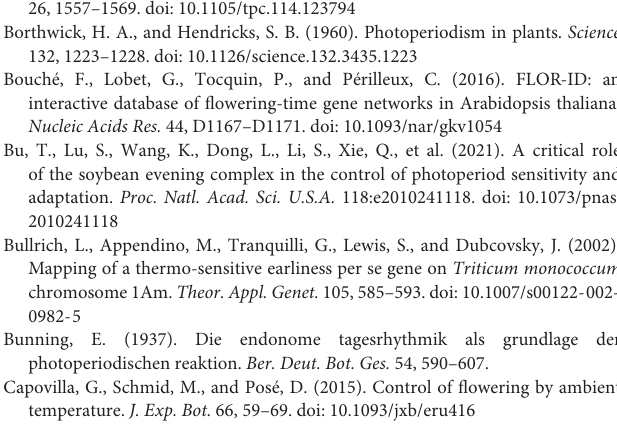
Supplementary Figure 1 | Spectra and light conditions records. (A) Spectral distribution of white, red, and far-red lights used during night breaks and end-of-day far-red treatments. (B) Diurnal monitoring of far-red, total light, and photosynthetically active radiations (PAR) intensities for plants exposed to 18 h long day (LD) followed by 1 h end-of-day far-red (FR) treatment (left) or not (right). Supplementary Figure 2 | Example of a Derived Cleaved Amplified Polymorphic Sequence for elf3 genotyping. The PCR was performed using the dCAPS primer pair shown in Supplementary Table 1 . The PCR product was digested using the hpy166ii restriction enzyme (NEB, United States), which cuts only into the WT ( + ) sequences, creating shorter fragments than in mutated ELF3 sequences (–). The elf3 mutant phenotypes segregated perfectly with the homozygous elf3 mutation. Supplementary Figure 3 | Complementation of elf3 mutant with the UBI:ELF3 construct. Six independent transgenic lines exhibited rescue of the rapid flowering phenotype in the T0 generation under 16-h LD. Controls were sown 3 weeks before transplantation of T0 lines to soil. The picture was taken 45 days after transplantation to soil. Supplementary Figure 4 | Flowering phenotype of elf3 mutants overexpressing VRN1 . Individuals were segregated from the elf3 ; UBI : VRN1 F2 population. The picture was taken 110 days after germination under 8 h SD. elf3 mutant flowered after 86.5 ± 13.7 days ( n = 15), elf3 ; UBI : VRN1 flowered after 36.3 ± 2.9 days ( n = 27). WT and UBI:VRN1 plants had not flowered after 180 days. Supplementary Figure 5 | Expression kinetics of CO1 in the elf3 mutant. Relative expression of CO1 during a 24 h time course for WT plants (black triangles) and elf3 mutants (blue circle) cultivated under 8, 12, 16, and 20 h photoperiods. Error bars represent the standard error of the mean. Data were normalized using the geometric mean of ACT3 and UBC18 . The white background indicates the light period, and the gray background shows the dark period. Time is expressed as the number of hours following the start of the light period (Zeitgeber time,